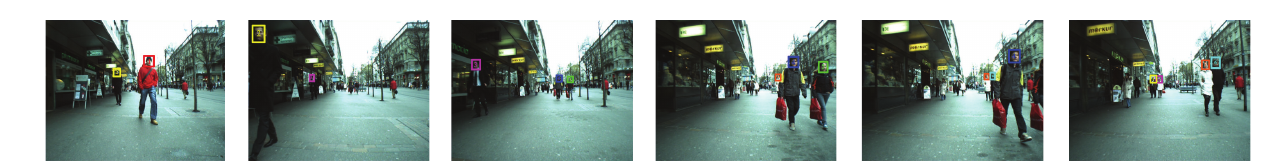
Figure 10: The typical results of Seq03view1 (Frame: 10, 40, 70, 100, 103, and 125).